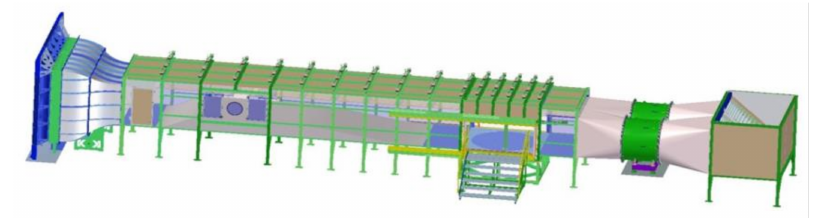
Figure 2. Wind tunnel in Bratislava,